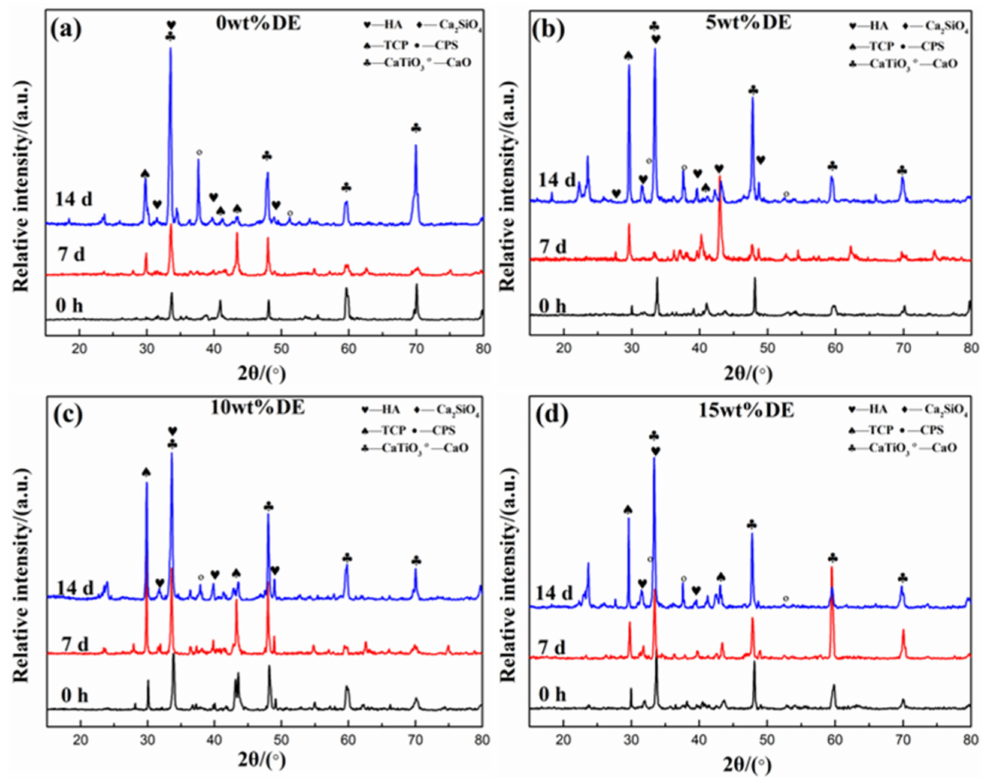
Figure 9. XRD patterns of bioceramic coatings with different contents of DE, ( a ) 0wt% DE; ( b ) 5wt% DE; ( c ) 10wt% DE; ( d ) 15wt% DE, before (0 h) and after (7 d, 14 d) soaking in